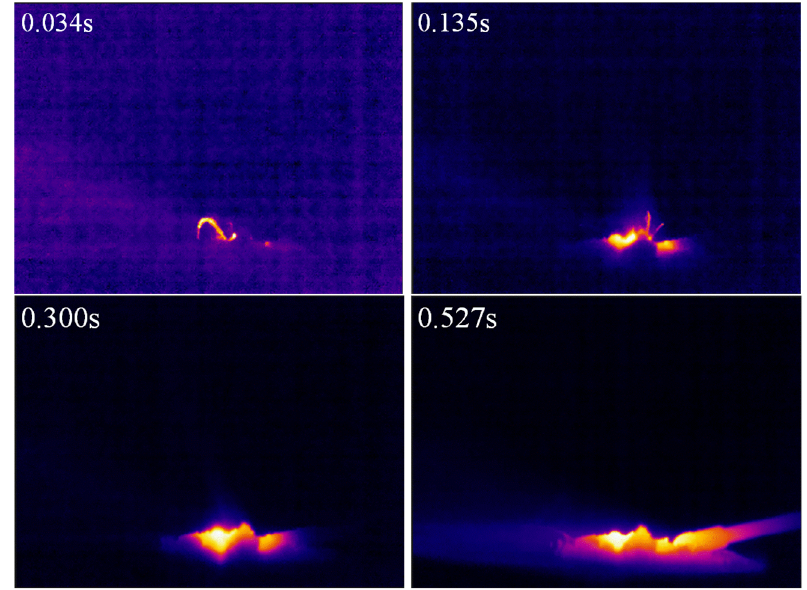
Figure 6. Infrared temperature measurements during ignition and combustion of the of the MgB 2 sample. Table 1. Infrared temperature of the MgB 2 sample at different time points.